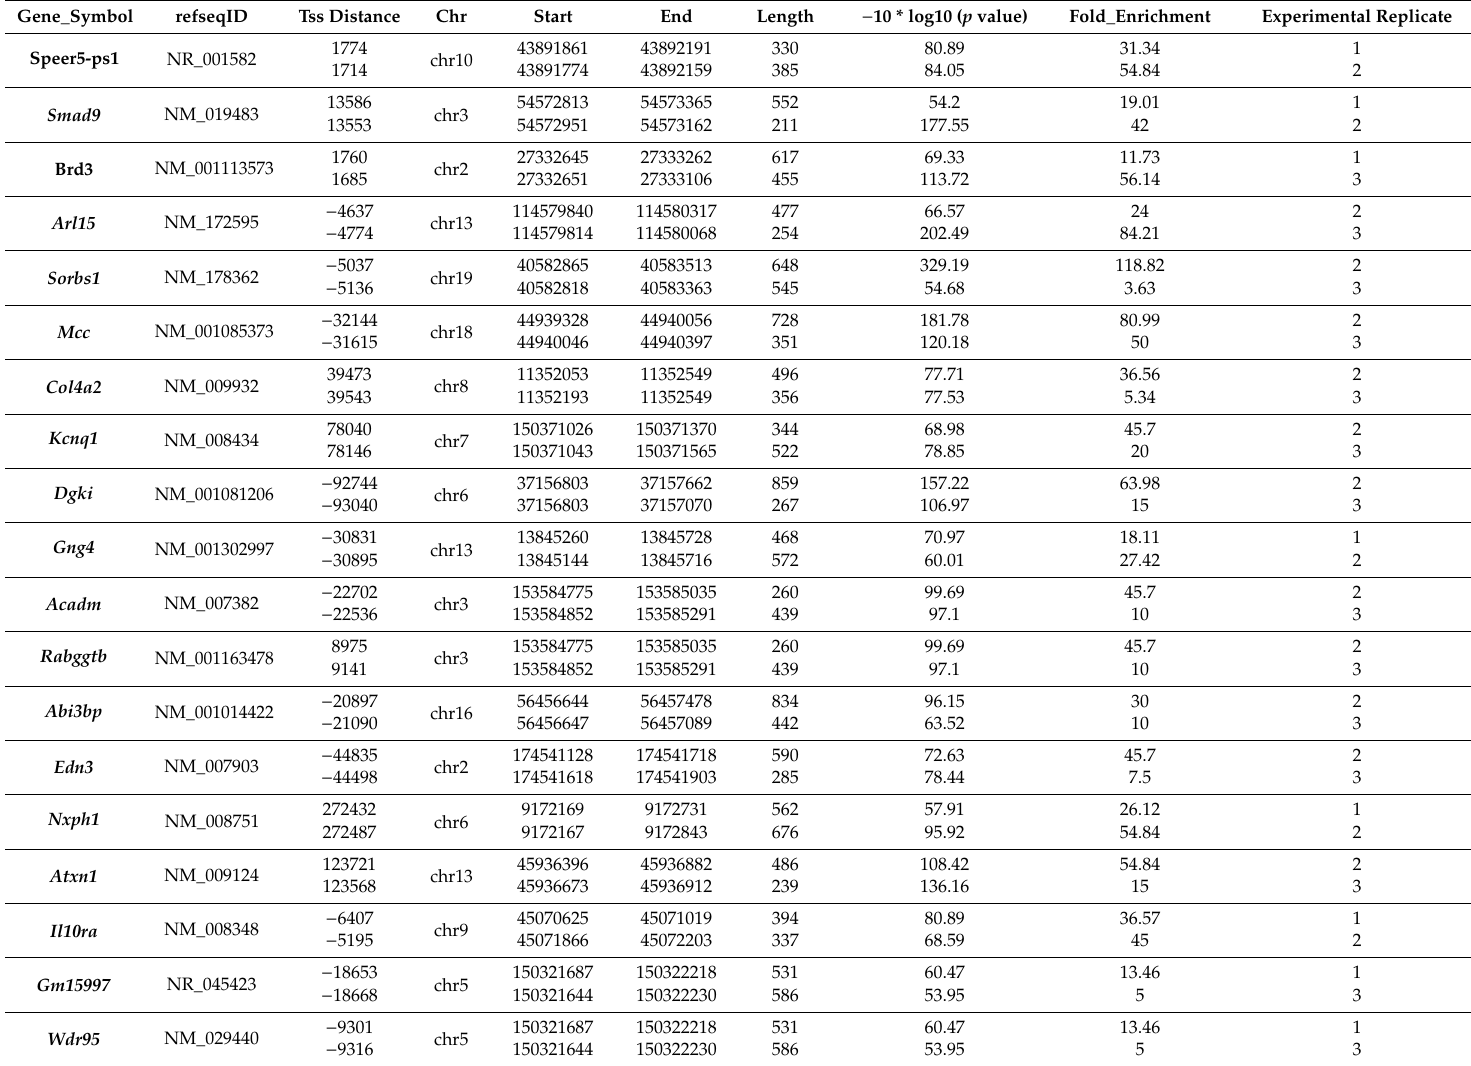
Table 1. PAX6 Target Genes and Their Corresponding Peaks Within Genome Identified in Mouse Neurosphere-Like Bodies (NLBs) Through ChIP-Seq